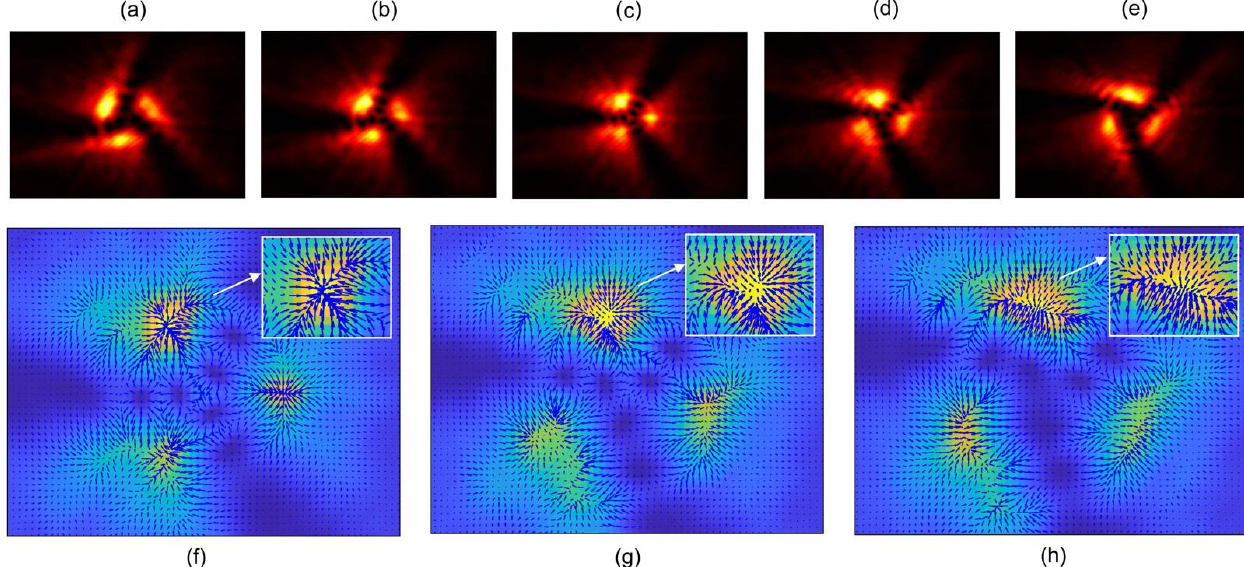
Setup 2 (Figure 4b). Figure shows the propagation of all Kinds and states (cid:96) = 1 to 6 for longer propagation.